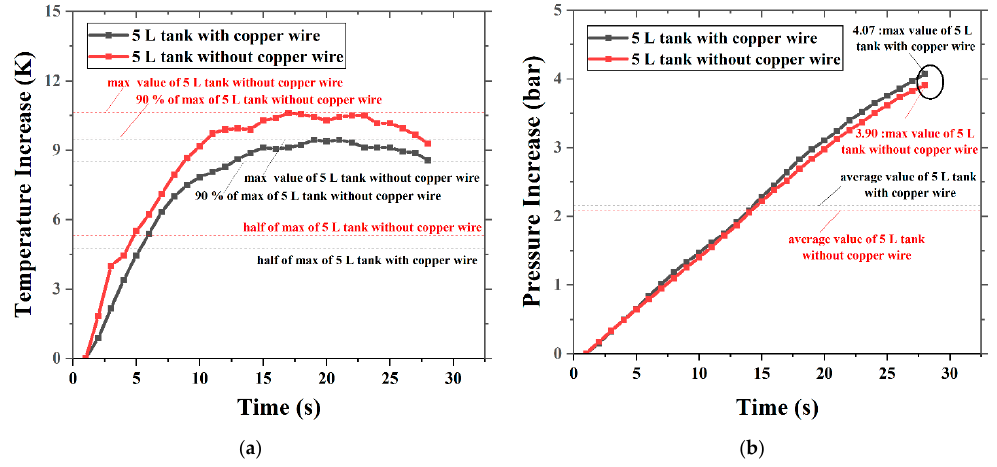
Figure 3. Experimental response of 5 L gas tank: ( a ) temperature response and ( b ) pressure response.